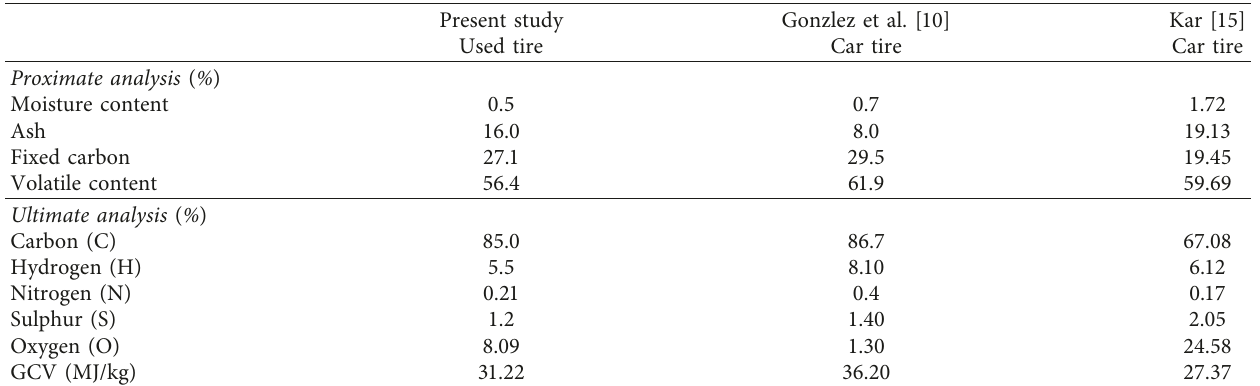
Table 3: HHV and ultimate and proximate analyses of used tires.